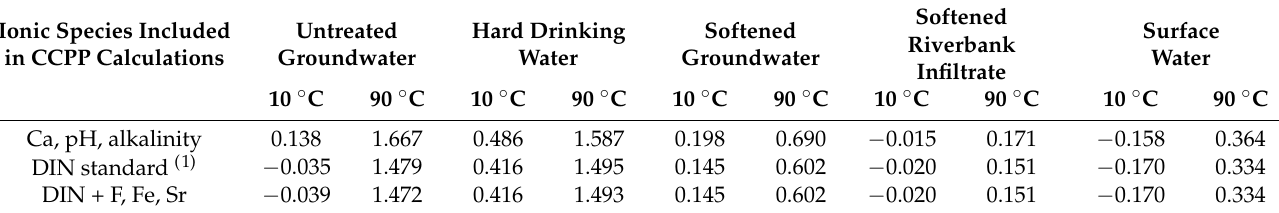
Table 3. Effect on varying numbers of ionic species on CCPP 10 and CCPP 90 : With Ca, pH and alkalinity only, with the ions included in the DIN 38404-10 standard [19] and with the DIN 38404-10 standard including F, Fe and Sr. The unit is